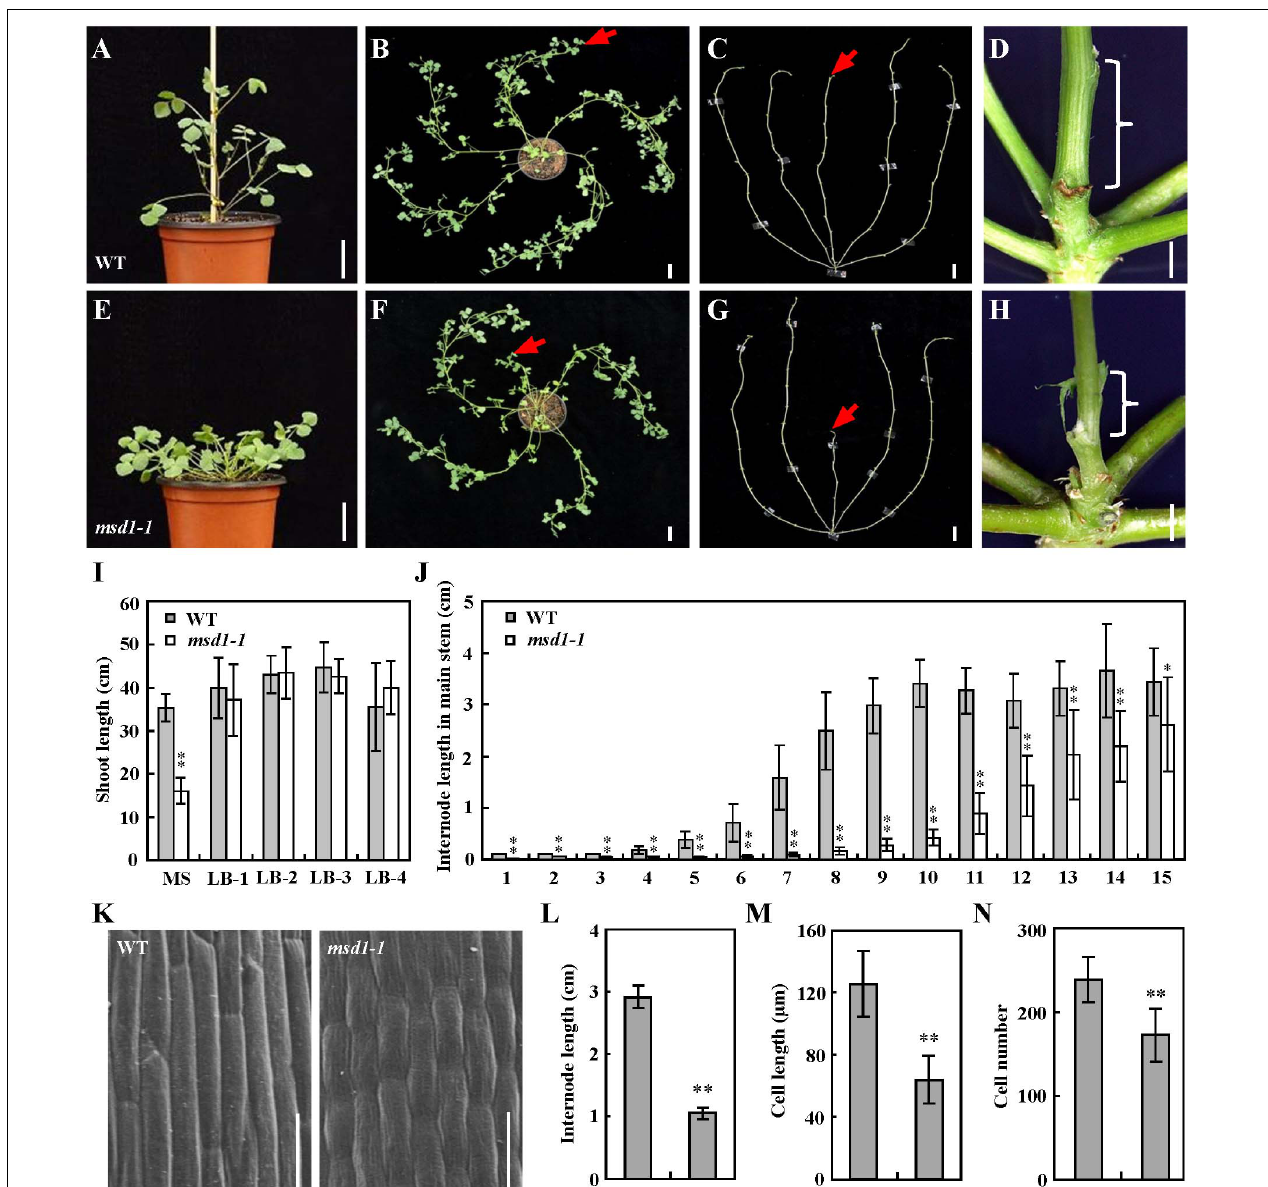
FIGURE 1 | Morphological comparison of the wild type and msd1-1 plants. (A–H) Phenotypic comparison of seedling and stem between wild type (WT) and msd1-1 . Seedlings of WT (A,B) and msd1-1 (E,F) at 5-week-old and 8-week-old, respectively, and 8-week-old bald stems without leaves in WT (C) and msd1-1 (G) plants. Bars = 3 cm; panels (D,H) are magnifications of shoot base in panels (C,G) , respectively. Bars = 2 mm. Red arrows indicate main stem, braces indicate main stem internode. (I) Comparison of shoot length between 8-week-old WT and msd1-1 plants. MS, main stem; LB-1, the first lateral branch; LB-2, the second lateral branch; LB-3, the third lateral branch; LB-4, the fourth lateral branch. Bars represent means ± SD ( n = 20); asterisks indicate significant differences from the WT ( ∗∗ P < 0.01, Student’s t- test). (J) Comparison of internode length between 8-week-old WT and msd1-1 plants. The x-axis represents corresponding node numbers. Bars represent means ± SD ( n = 20); asterisks indicate significant differences from the WT ( ∗∗ P < 0.01, Student’s t- test). (K) Scanning electron microscope images of the seventh internode of WT and msd1-1 plants. Bars = 50 µ m. (L) Comparison of the seventh internode length between 8-week-old WT and msd1-1 plants. Bars represent means ± SD ( n = 10); asterisks indicate significant differences from the WT ( ∗∗ P < 0.01, Student’s t- test). (M,N) Comparison of cell length (M) and cell number (N) in the seventh internode between 8-week-old WT and msd1-1 plants. Bars represent means ± SD ( n = 15); asterisks indicate significant differences from the WT ( ∗∗ P < 0.01, Student’s t-